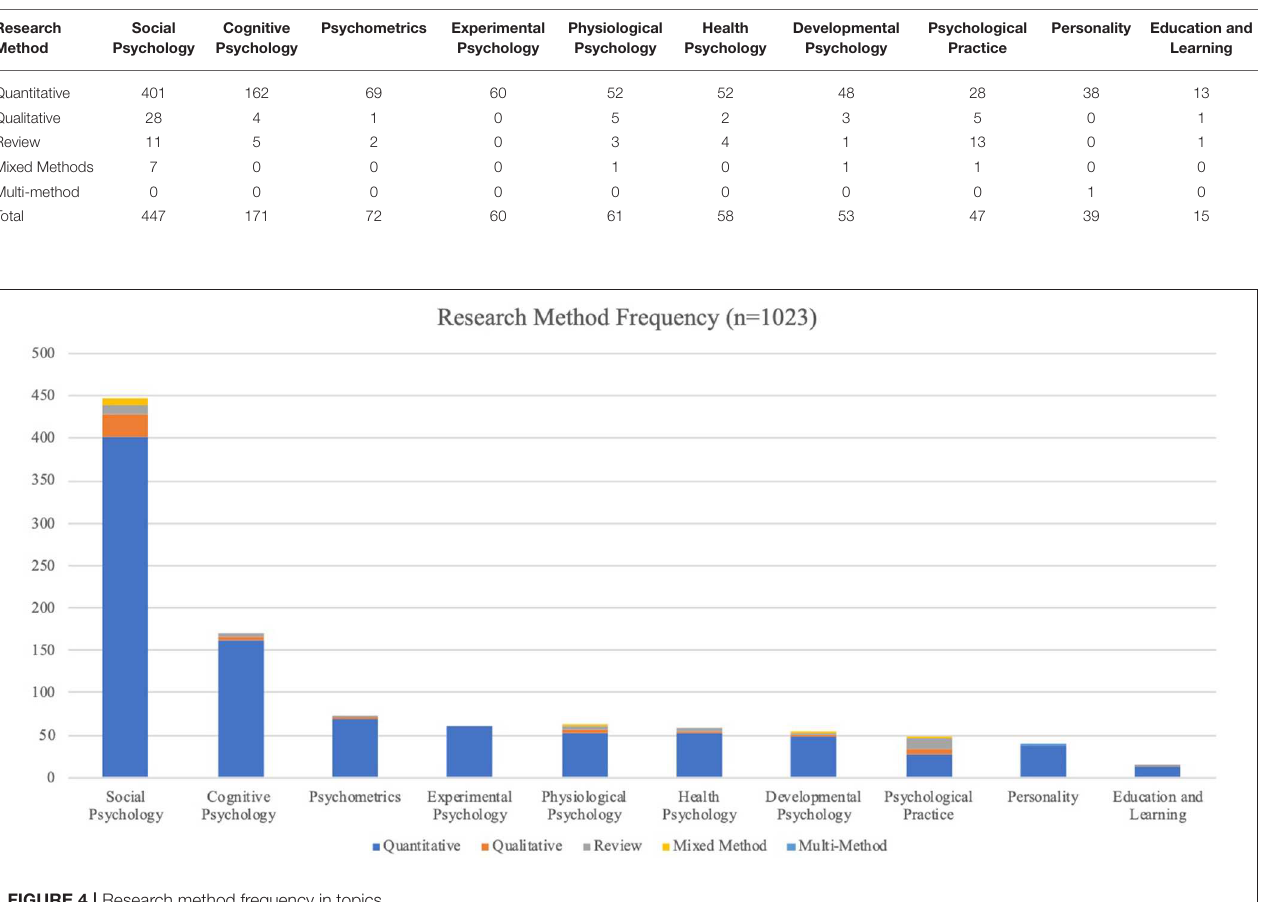
TABLE 2 | Research methods in psychology.